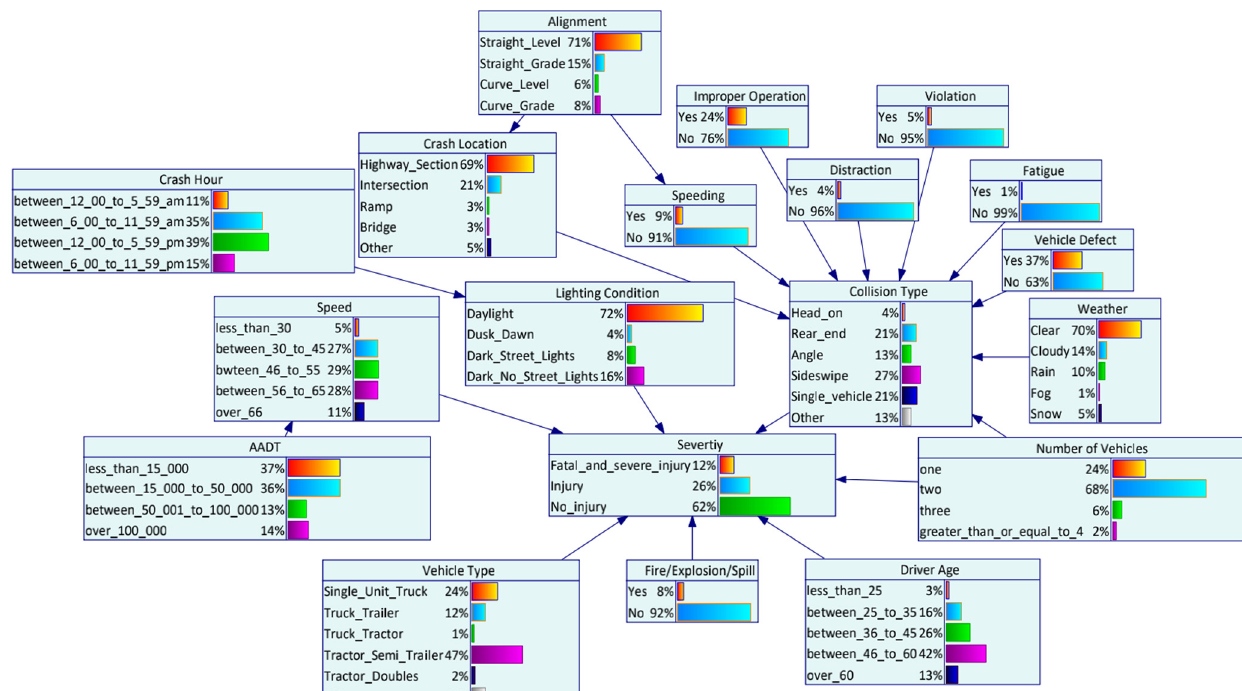
Figure 4. The Bayesian network parameter learning.